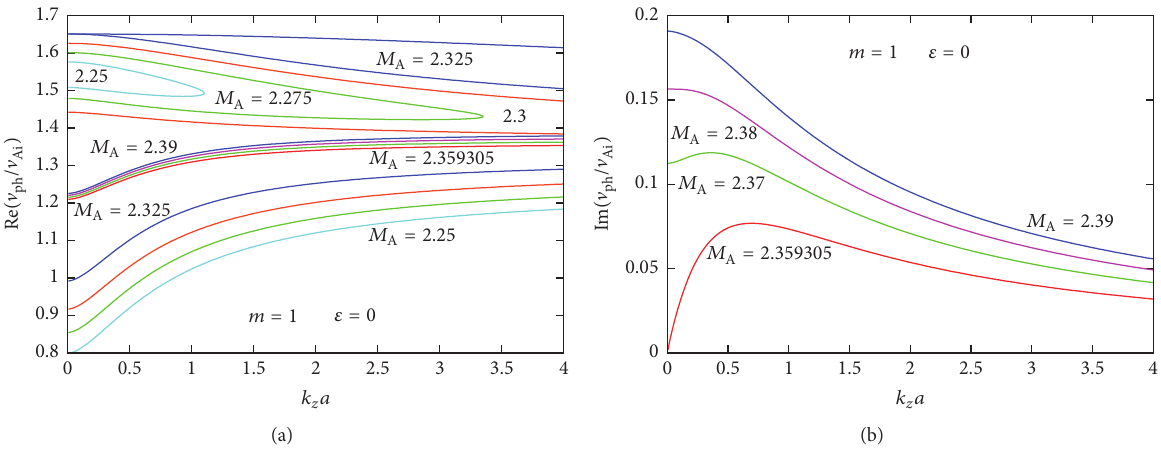
Figure 5: (a) Dispersion curves of stable and unstable kink ( 𝑚 = 1 ) MHD mode propagating in a moving untwisted magnetic flux tube of compressible plasma (modeling jet #16) at 𝜂 = 0.95 and 𝑏 = 1.32 . Dispersion curves of unstable modes located in the middle of the plot have been calculated for 𝑀 A = 2.359305 , 2.37 , 2.38 , and 2.39 . (b) Plots of corresponding normalized growth